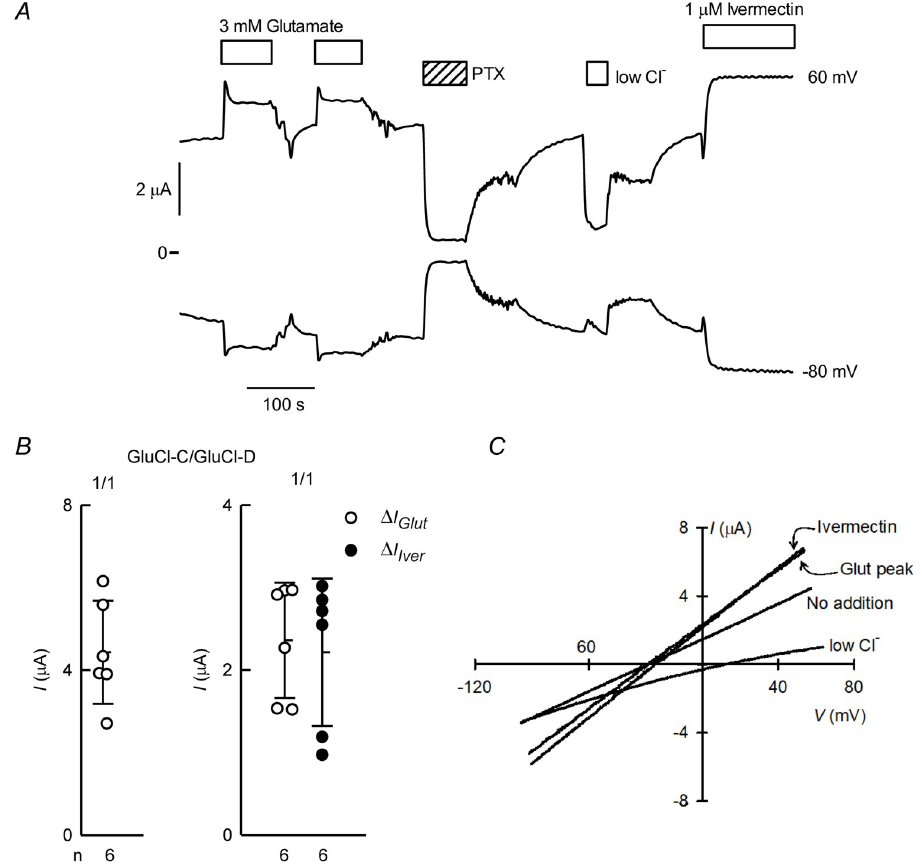
Fig 11. Functional properties of CrGluCl-D and CrGluCl-C expressed in Xenopus oocytes. A. Spontaneous currents in an oocyte expressing subunits D and C after microinjection of 10 ng cRNA for each CrGluCl-D and CrGluCl-C. The effects of 3 mM glutamate or 1 μ M ivermectin, as well as that of partial chloride removal and PTX addition are also shown. Recording shown were taken at 60 mV and -80 mV. B. Summary of spontaneous currents (at 60 mV) in oocytes expressing CrGluCl-D and CrGluCl-C subunits (left) together with data for the extra current elicited by glutamate or ivermectin (right). Total cRNA injected was always 20 ng. Data points report individual measurements with means ± SDs also shown, n indicated under the abscissa. C. IV relations corresponding to the spontaneous currents before any addition (No addition), at the peak of the glutamate response, after ivermectin challenge and after partial chloride removal or PTX